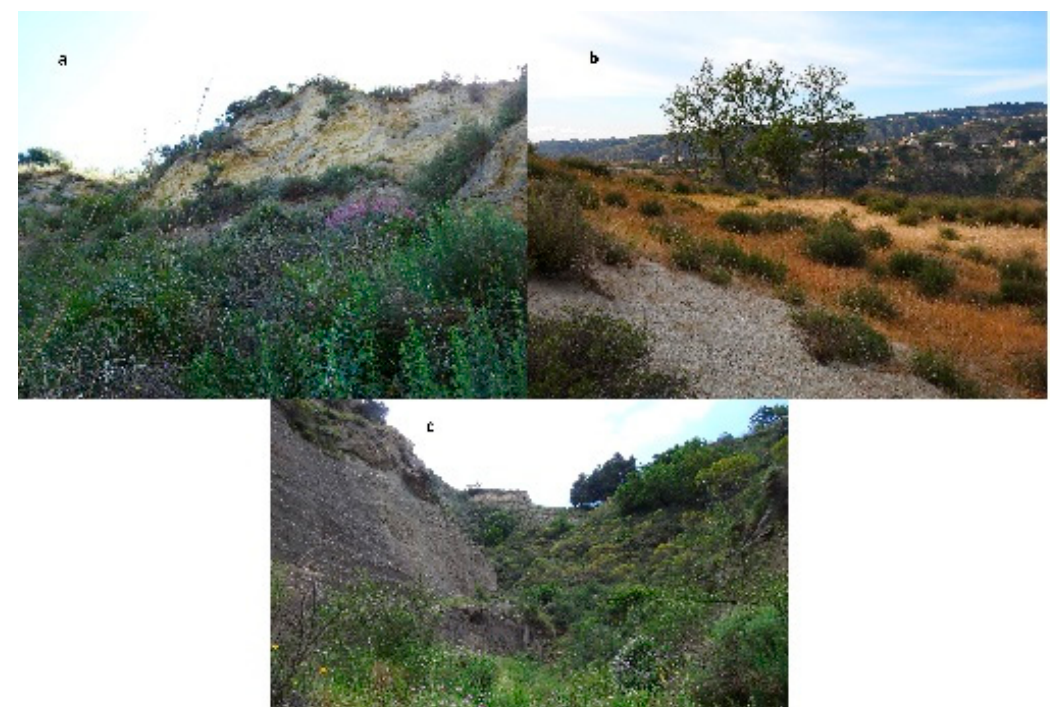
Figure 2. Habitat of S. ceratophylloides : ( a ) Mediterranean grasslands with Ampelodesmos mauritanicus (Poir.) Dur. & Schinz.; ( b ) vegetation of the sands with Artemisia campestris subsp. variabilis (Ten.) Greuter; ( c ) garrigue with Cistus creticus L.